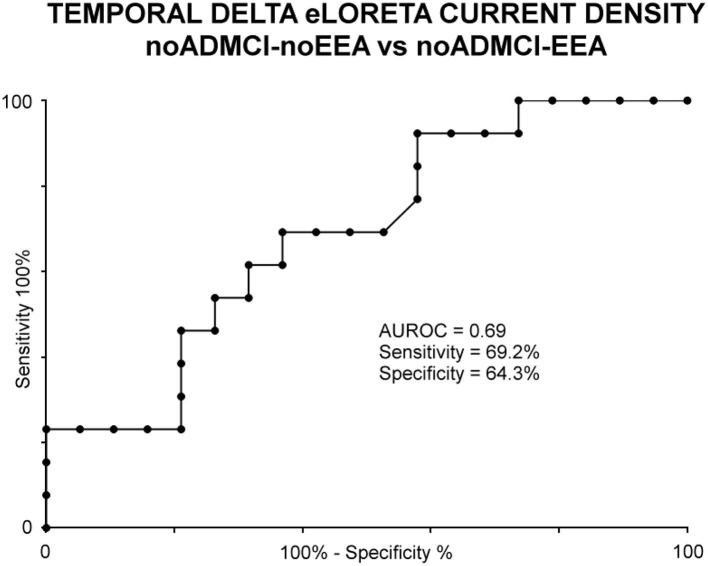
Receiver operating characteristic (ROC) curve illustrating the classification of the noADMCI-noEEA (N = 19) and noADMCI-EEA (N = 13) individuals based on regional normalized eLORETA solutions (log-10 transformed) modeling temporal delta sources. The area under the receiving operator characteristic (AUROC) curve showed moderate classification accuracies.